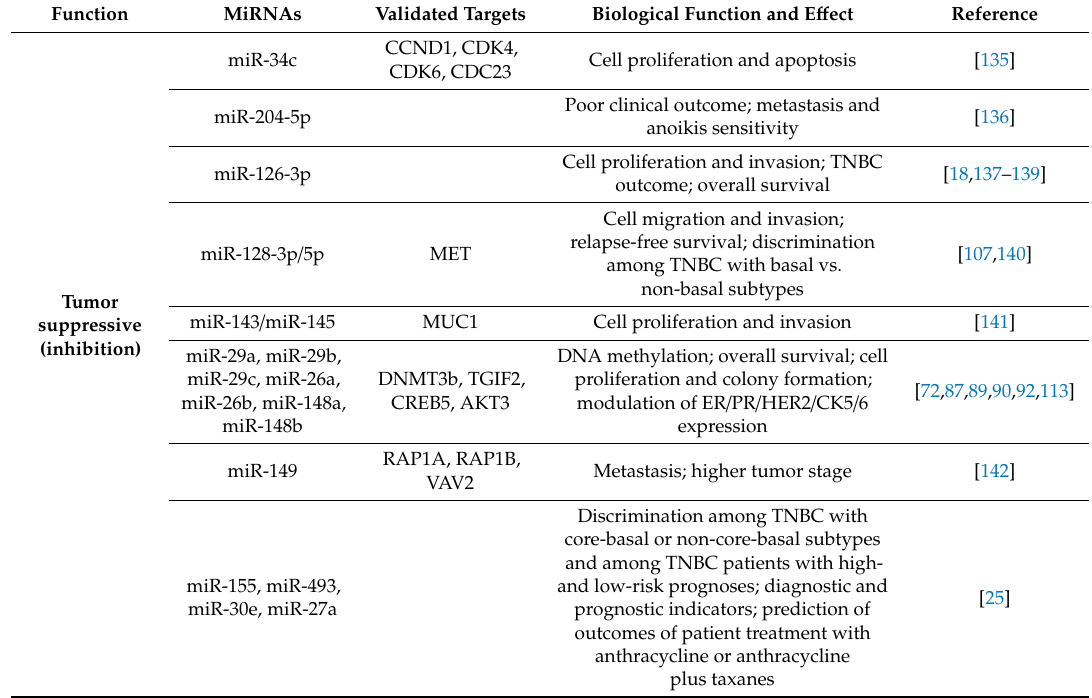
Table 1. miRNA biological function and e ff ect in TNBC with basal-like